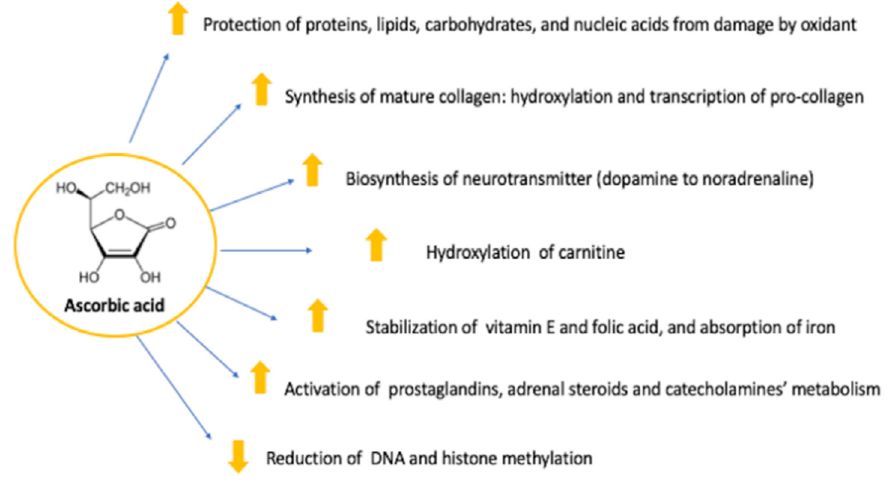
Figure 1. Roles of ascorbic acid in several biochemical reactions .